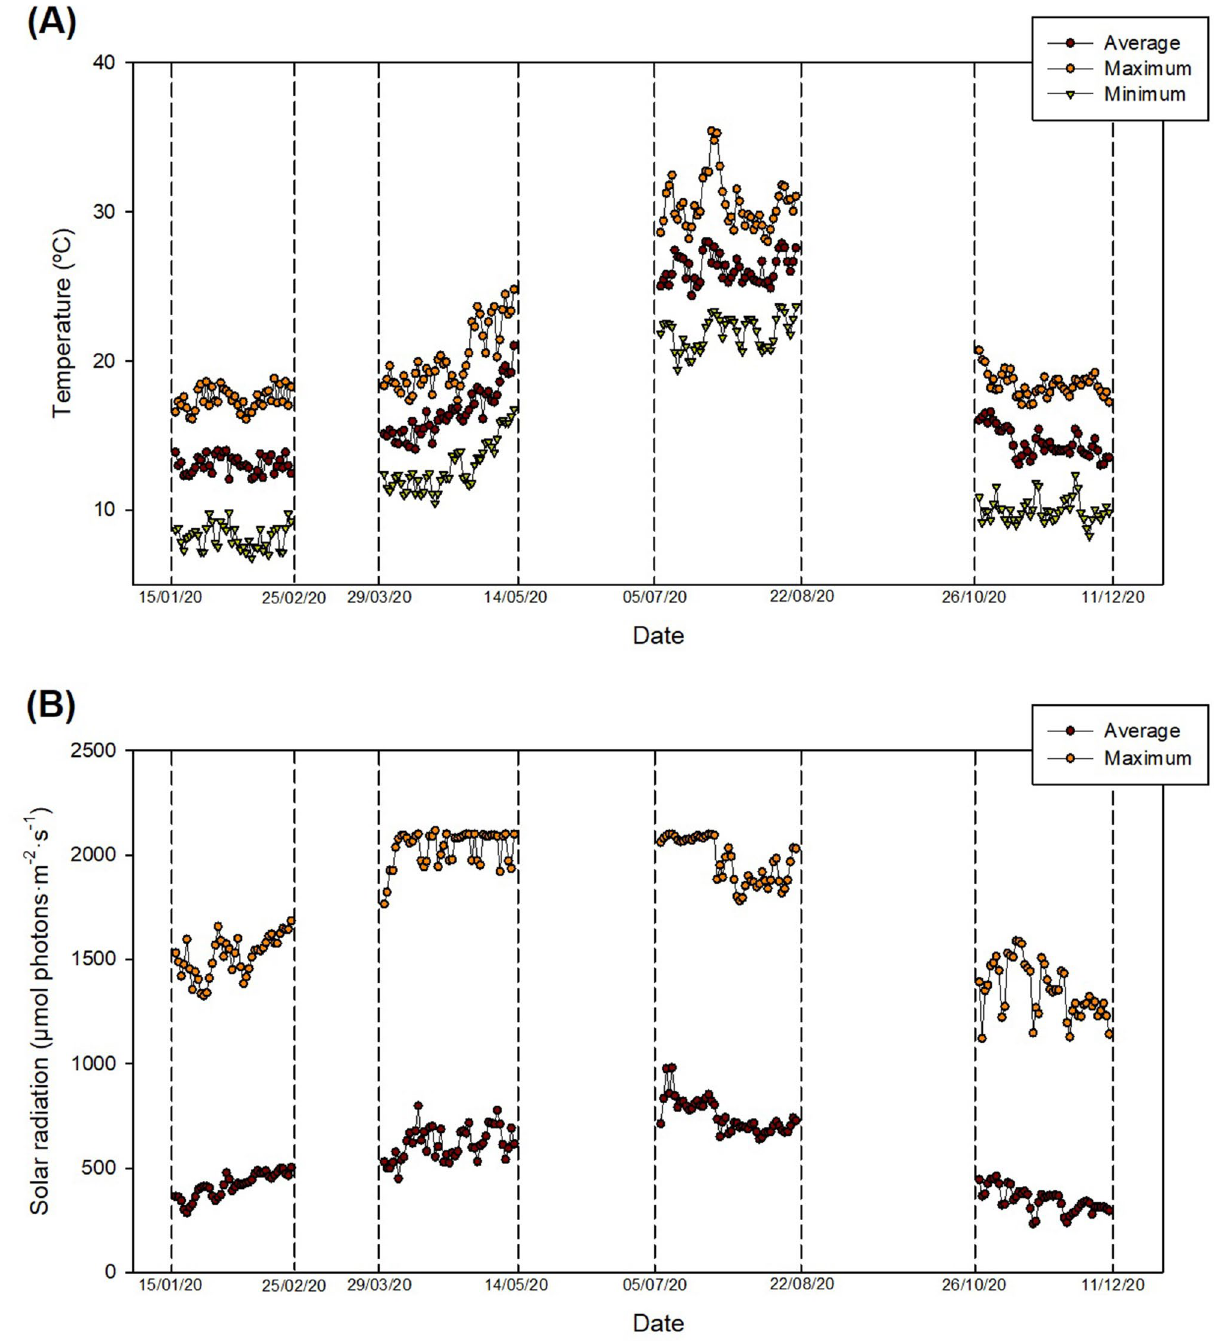
Figure 1. (A) Temperature and (B) solar radiation during the experimental runs. Determinations were conducted every 1 s. Average values represent the average of all the measurement taken in one day. Maximum and minimum values represent the maximum and minimum temperature or solar radiation value determined per day. Figure made using SigmaPlot v11.0 (Systat Software Inc., CA,